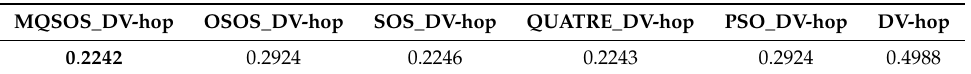
Table 3. Four positioning